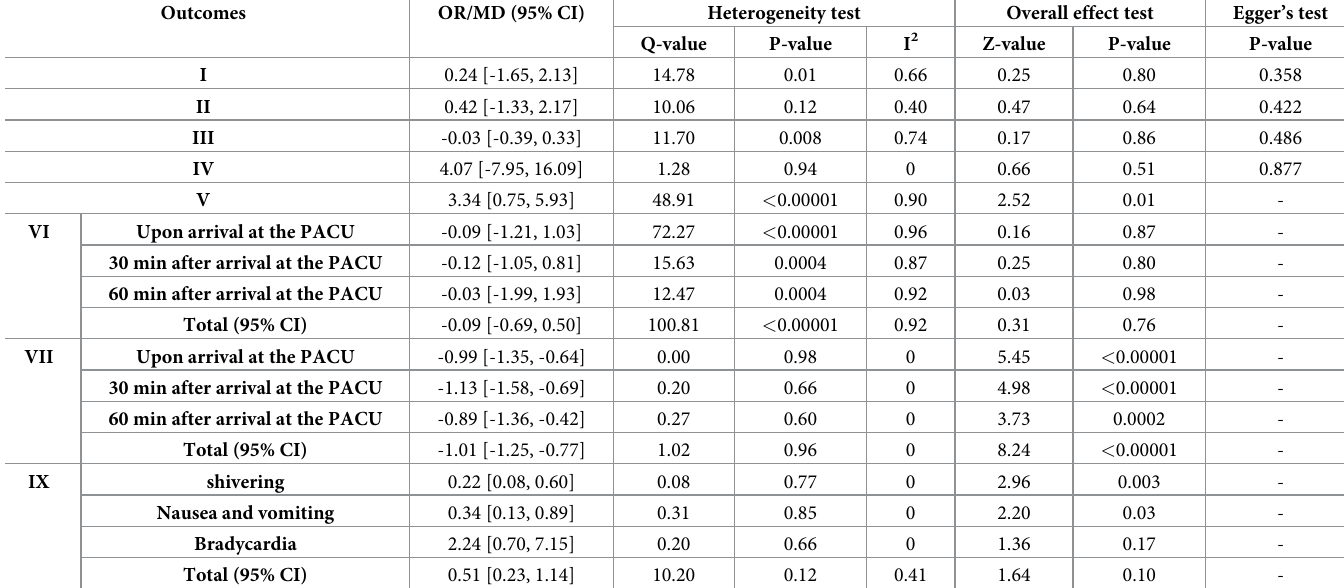
Table 2. Result summaries of this meta-analysis.